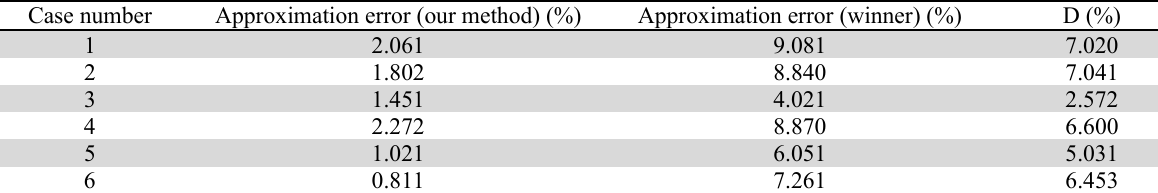
Fig. 9. Comparing our vs. the winners method'. (a) Benefit, (b) Cost approximation error achieved from Margin between cost approximation errors with vs. without applying the proposed